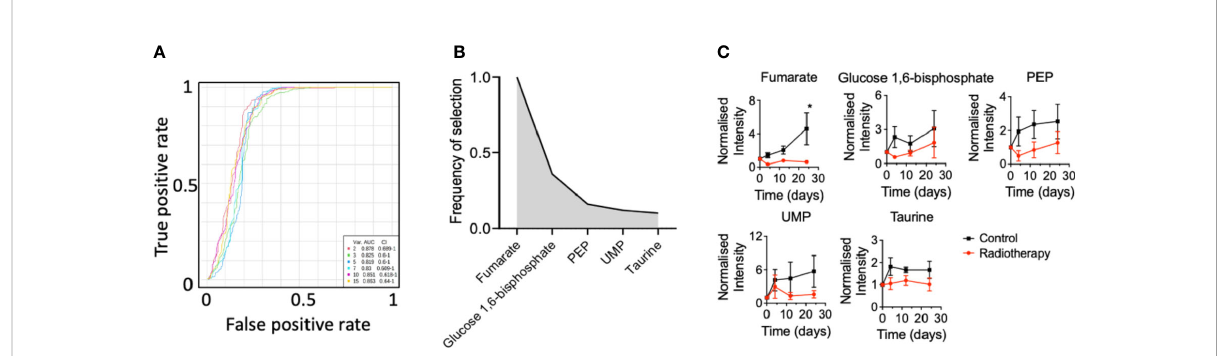
FIGURE 2 Plasma biomarkers of radiation for an astrocytoma mouse model: (A) , Multivariate ROC curve diagram for those metabolites selected by MEBA with the highest potential as plasma biomarkers based on the area under the curve. (B) , Top-5 ranked variables included in the multivariate ROC curve analysis and (C) their levels over time (n=5 mice per group, metabolites levels are displayed as mean ± SEM, signi fi cance assessed by a two-way ANOVA for repeated measures followed by Sidak ’ s test for multiple comparisons. *,